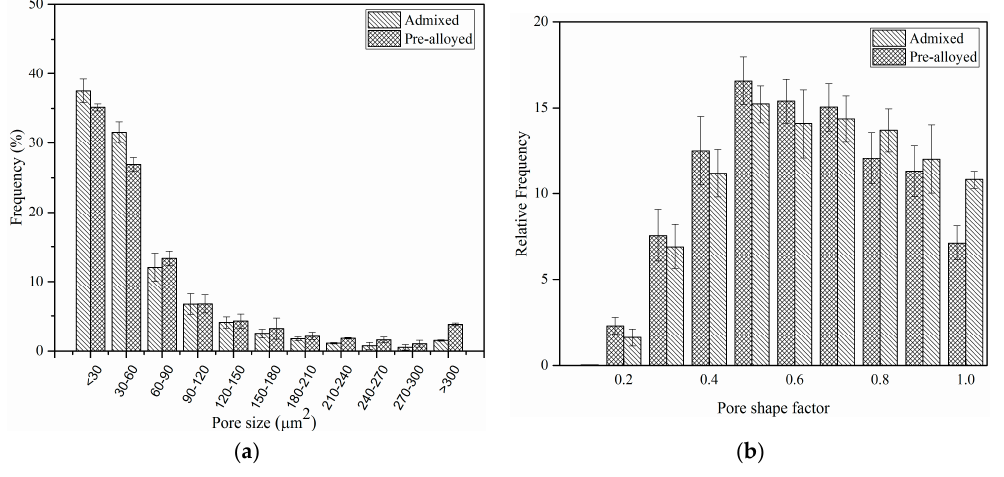
Figure 2. Distribution of the pore ( a ) size and ( b ) shape for both admixed and pre-alloyed sinter-hardened PM steels.